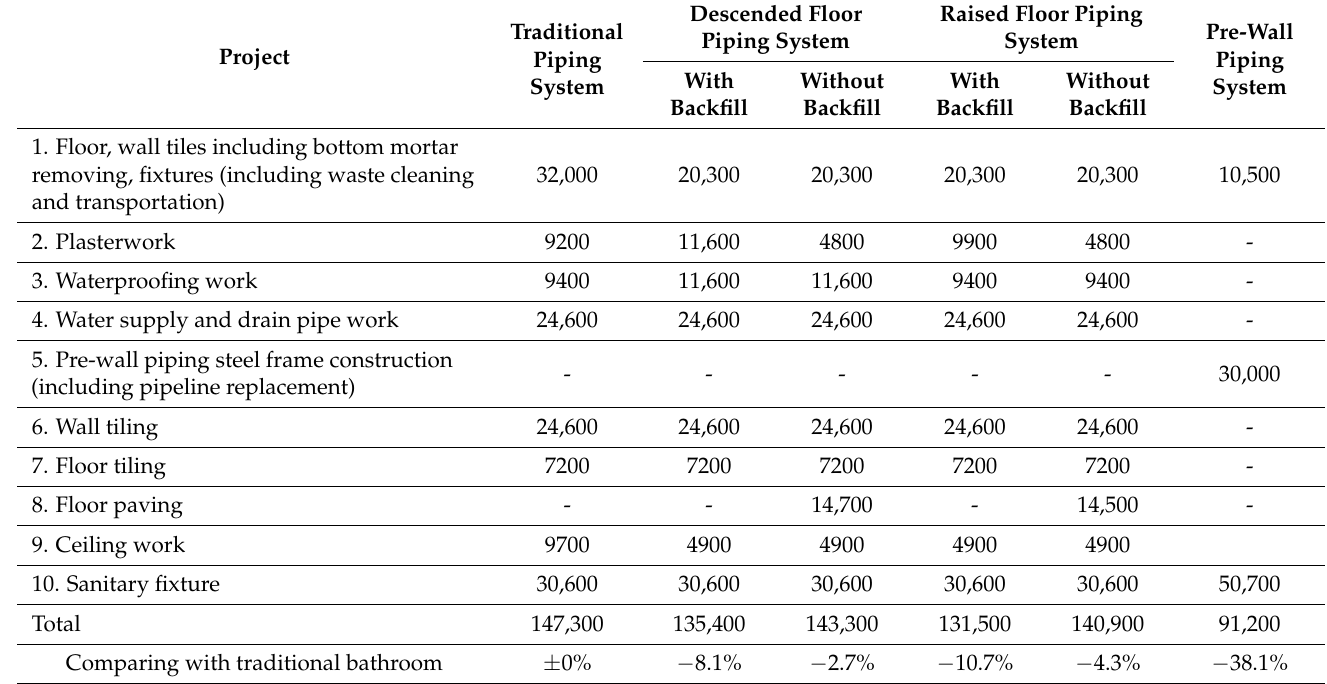
Table 2. Costs for complete replacement of pipelines in the four types of bathroom piping systems. Project